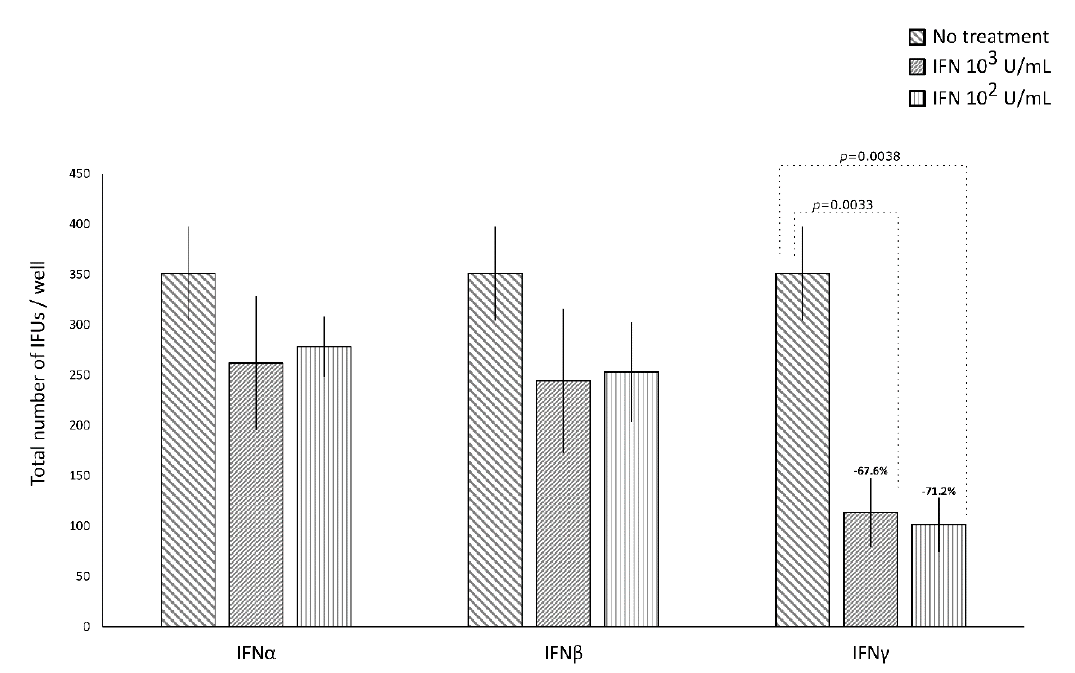
Figure 1. Anti-chlamydial activity of interferon (IFN) α , IFN β , and IFN γ following the pre-infection treatment of human synovial fibroblasts. Confluent monolayers pre-treated with the IFNs (10 2 or 10 3 IU / mL) for 24 h, were infected with C. trachomatis . The total number of IFUs was determined by fluorescence microscopy, counting all green-stained inclusions at 400 × magnification.